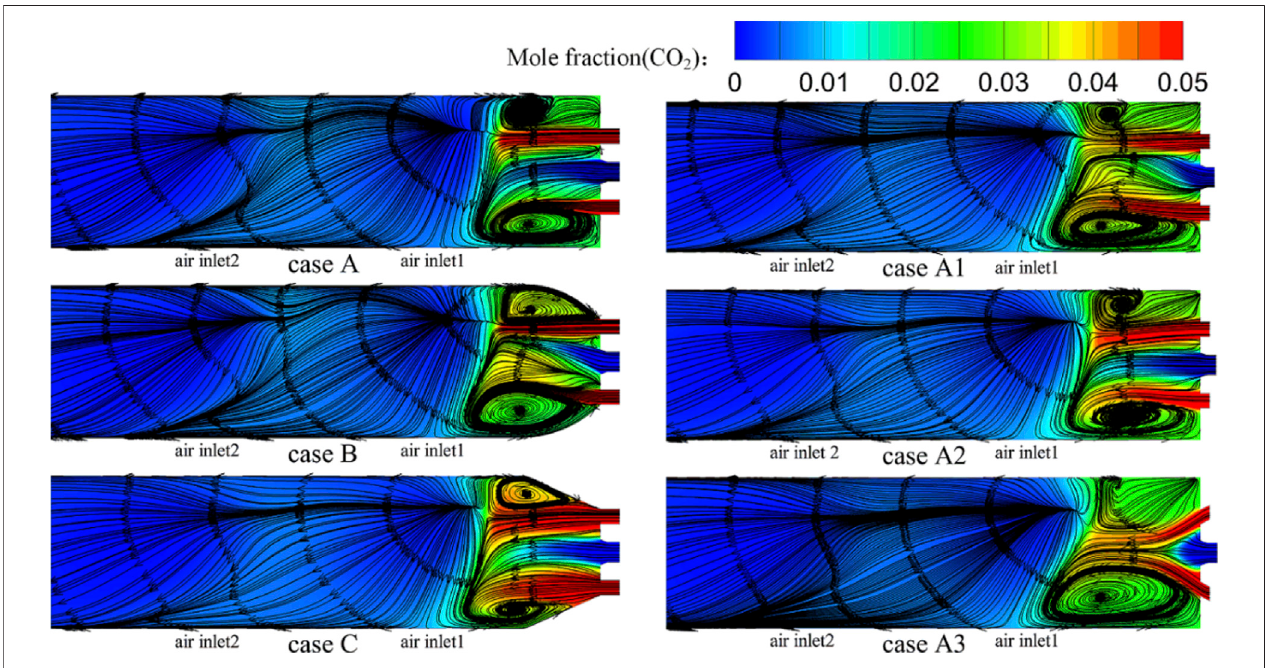
FIGURE 8 | Contours of the mole fraction (CO 2 ) and streamline distributions on the x-z .